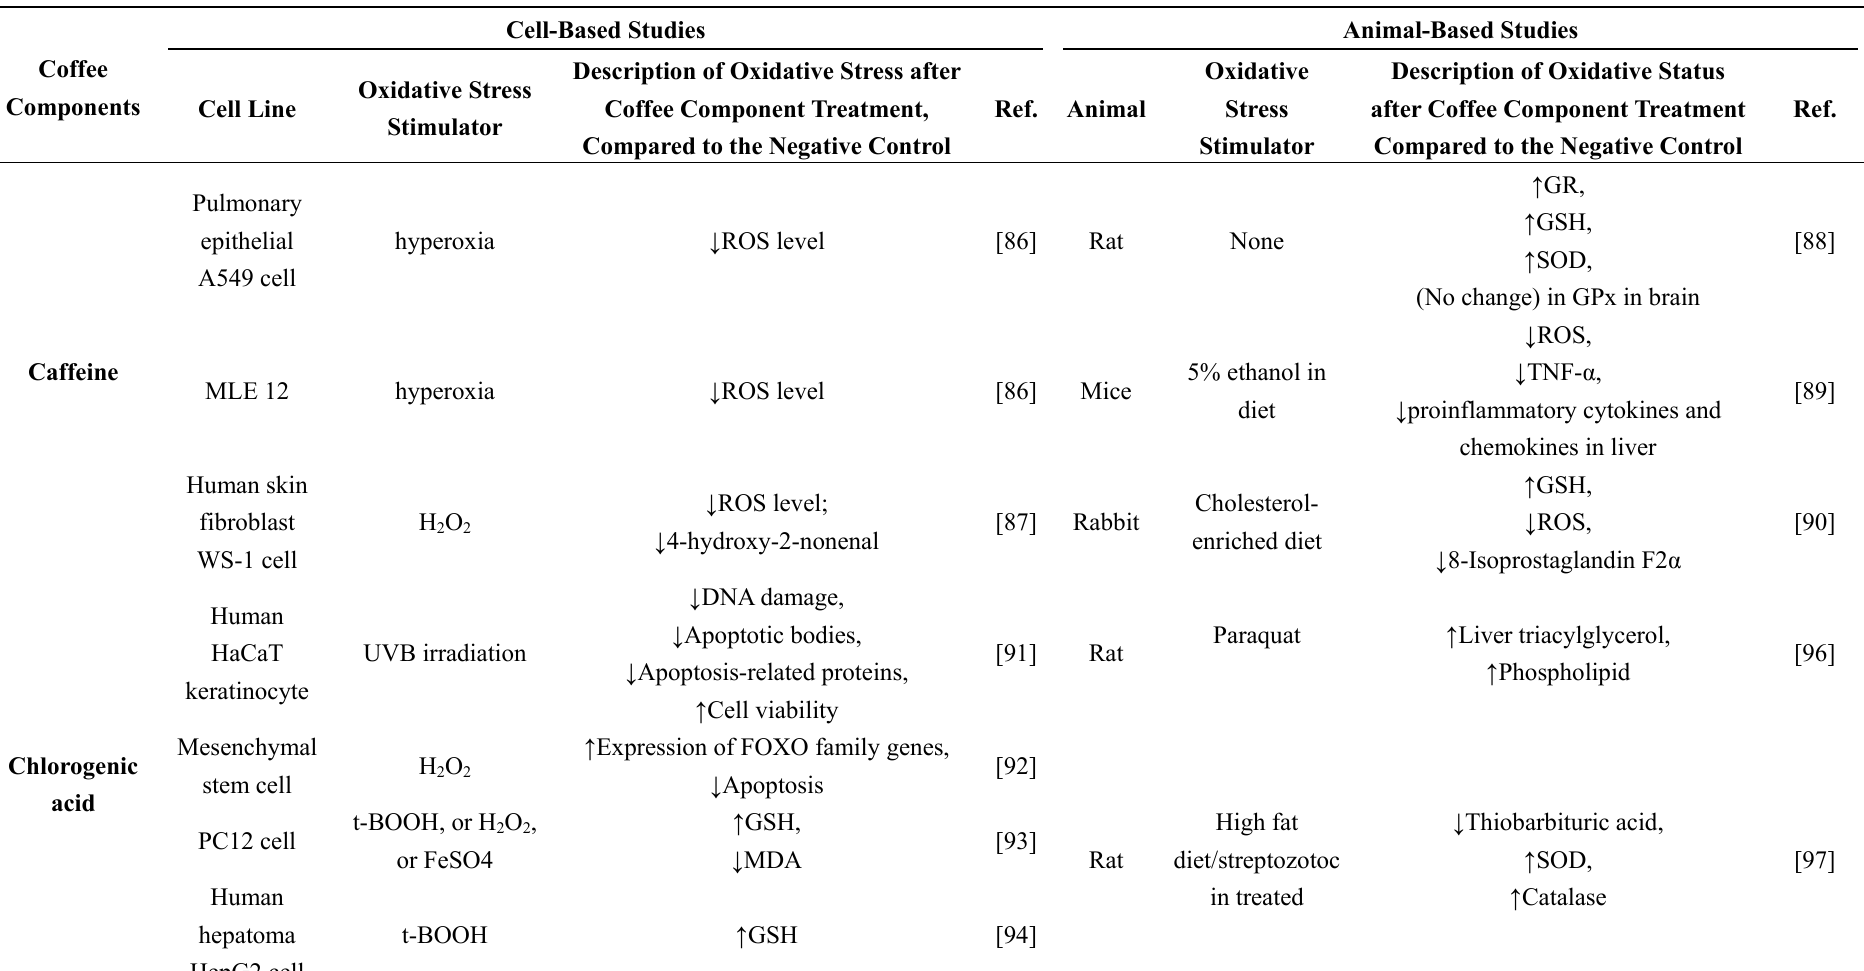
Table 2. Summary of cell-based and animal-based studies on evaluating the effects of coffee components on modulating oxidative status. Coffee